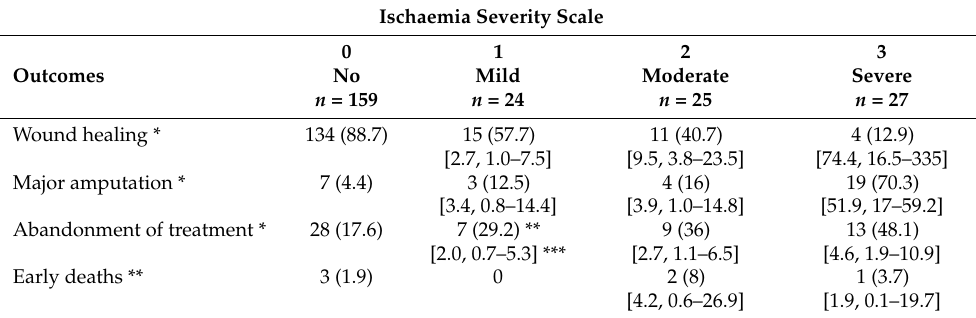
Table 3. Outcome rates and odds ratio for ischaemia severity scale in diabetic foot patients. Ischaemia Severity